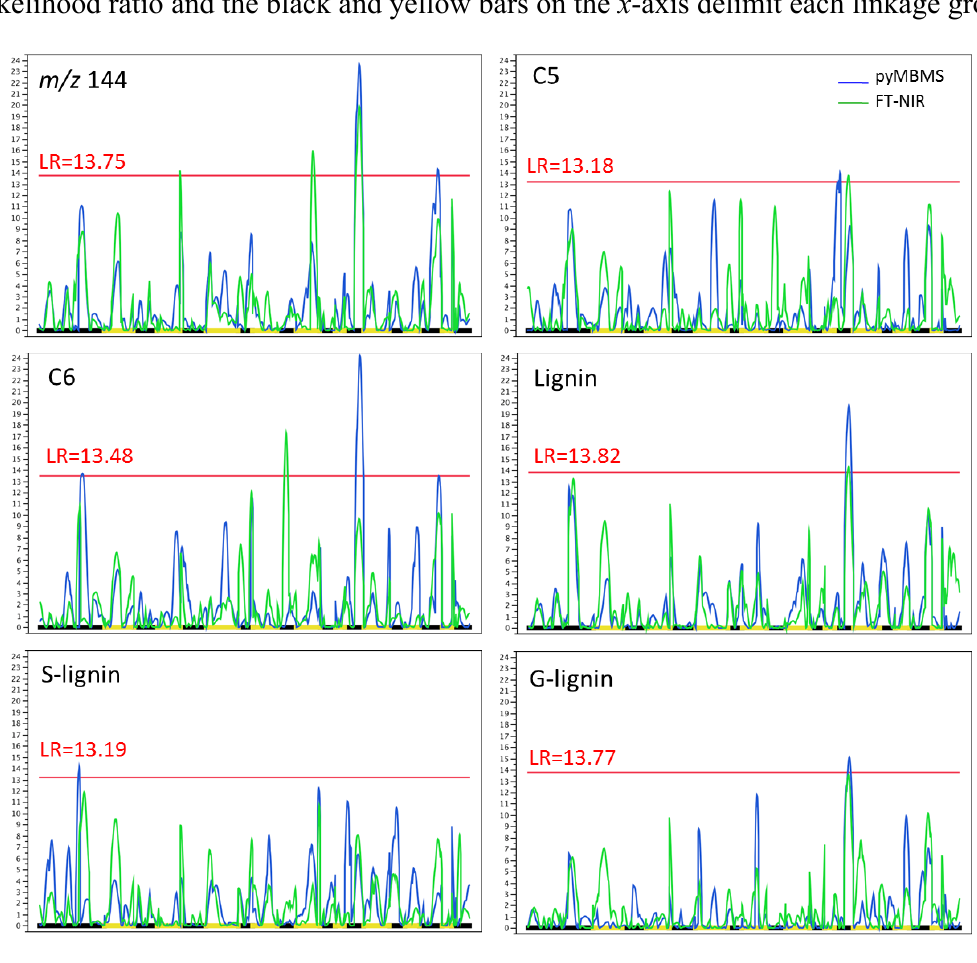
Figure 3. QTL profiles for pyMBMS (blue) and FT-NIR (green) predictions for six wood chemistry traits. The FT-NIR predictions were conducted with the 500 samples calibration set. The likelihood ratio (LR) threshold is indicated in each figure (red line), the y -axis is the likelihood ratio and the black and yellow bars on the x -axis delimit each linkage